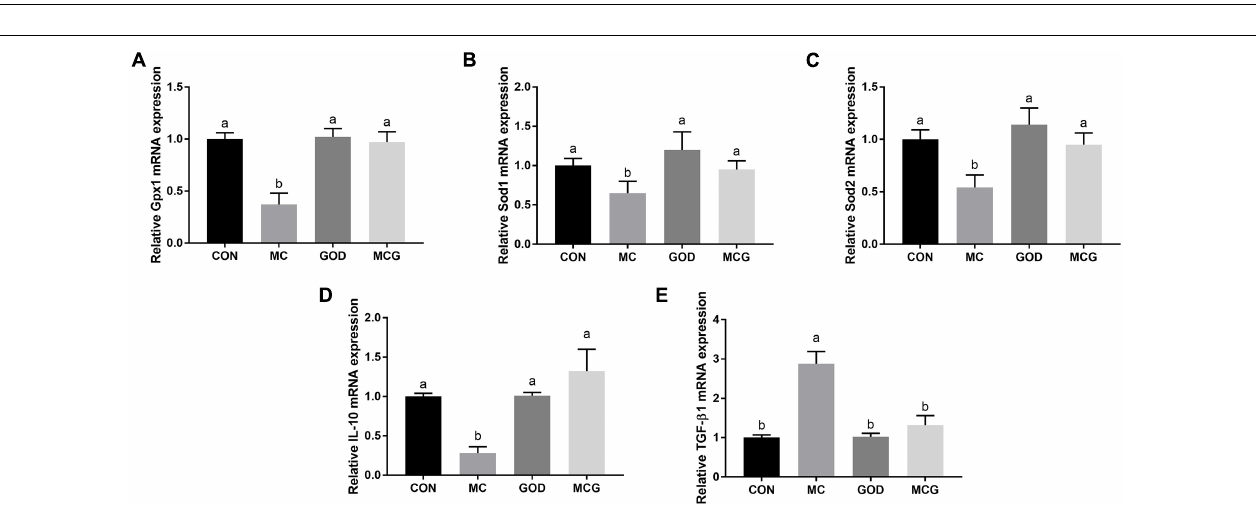
FIGURE 3 | Effects of glucose oxidase on intestinal protein expression of ZO-1, claudin-4, and NF- κ B in the broiler chickens fed mold contaminated corn. (A) Western blotting results; relative protein expression of ZO-1 (B) , claudin-4 (C) , and phosphorylated NF- κ B (D) . ZO-1 and claudin were normalized to GAPDH. pNF- κ B was normalized to NF- κ B. a , b Means with different letters within columns indicates significant differences at P ≤ 0.05. n = 3.